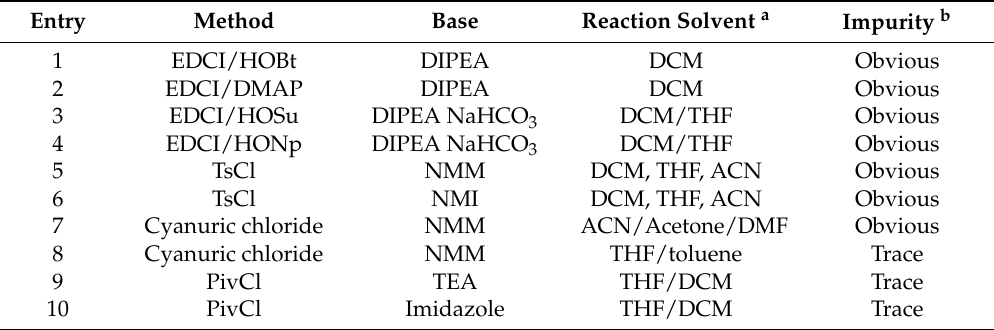
Table 1. Coupling reaction conditions optimization in the synthesis of 4 .